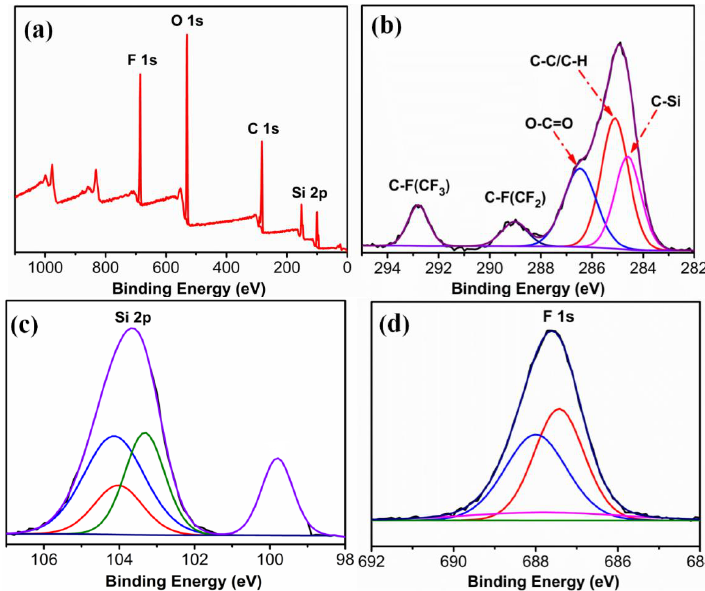
Figure 7. XPS and high-resolution spectra of FSi@SiO 2 on the silicon wafer: ( a ) wide scanning; ( b ) C1s; ( c ) Si2p; and ( d ) F1s.